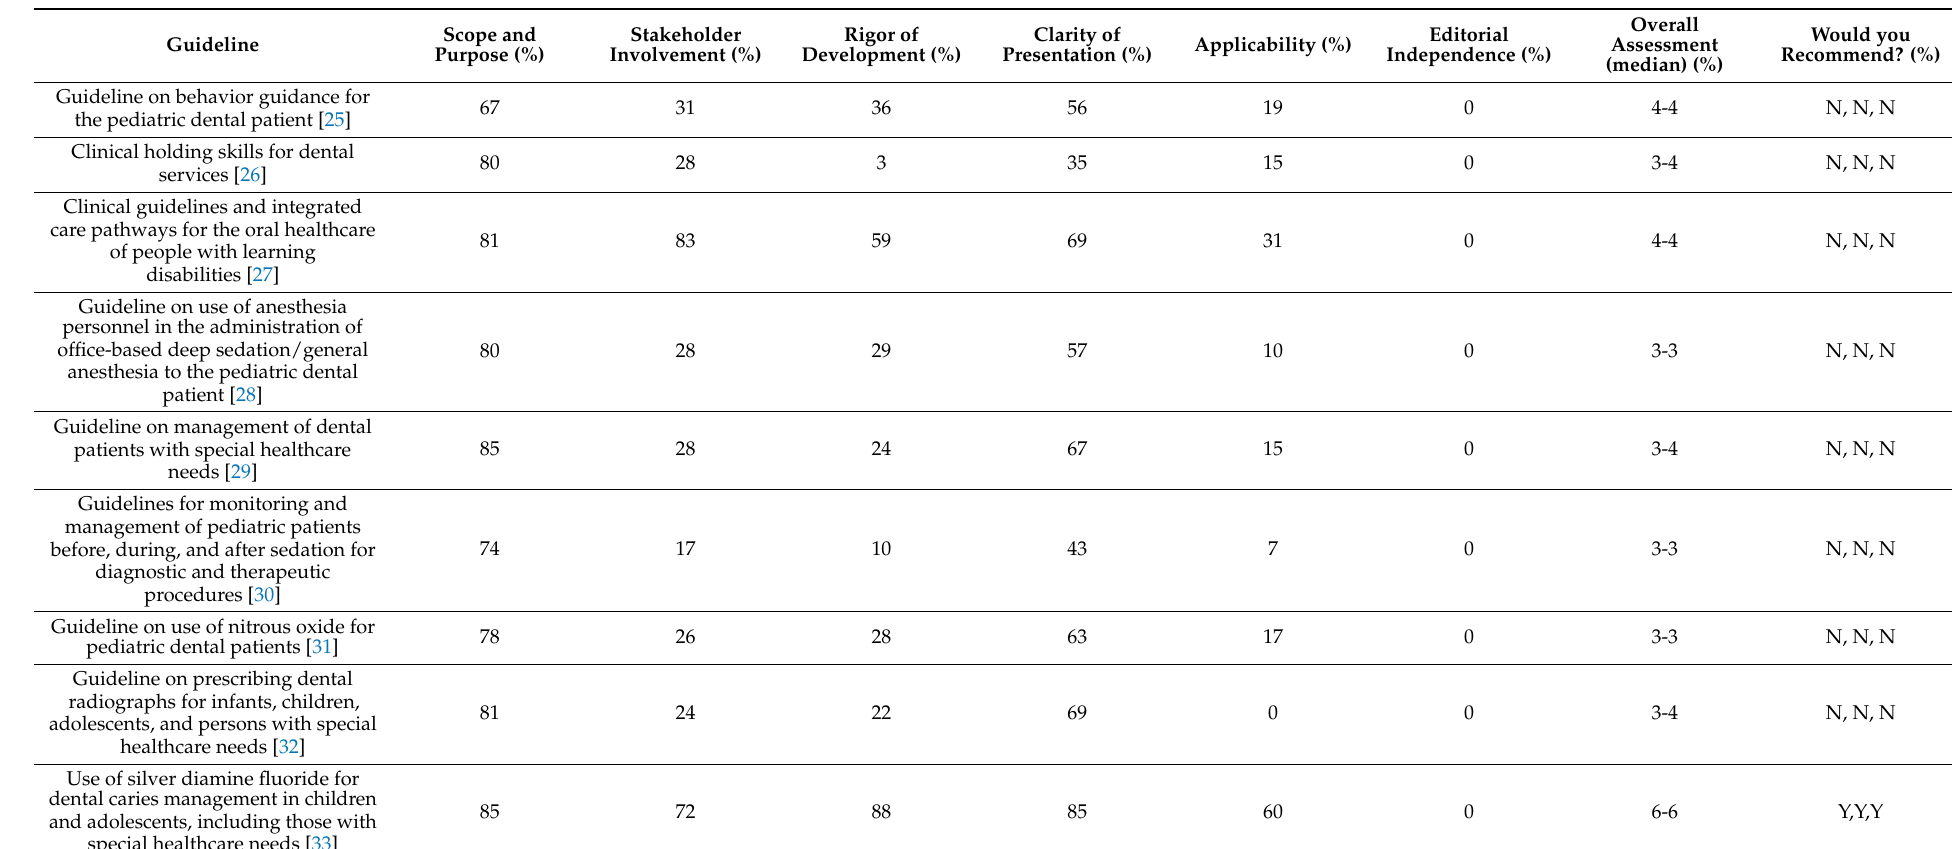
Table 2. The overall scores for each included guideline by the AGREE II